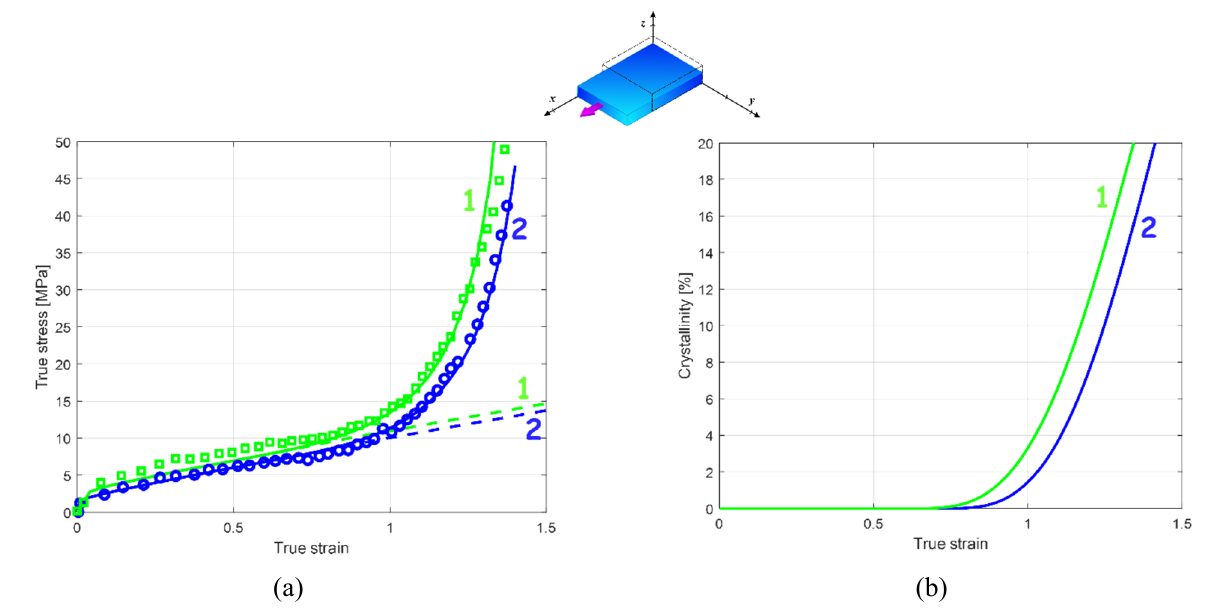
Figure 6. Model results under CW loading at a loading temperature of 87 ◦ C and different strain rates (1: 1 /s, 2: 4 /s): (a) stress-strain response, (b) strain-induced crystallization; Solid lines: model; Dashed lines: model with no crystallization; Symbols: experimental data of Buckley et al. [1].